Question: In one sentence, what is this figure communicating?
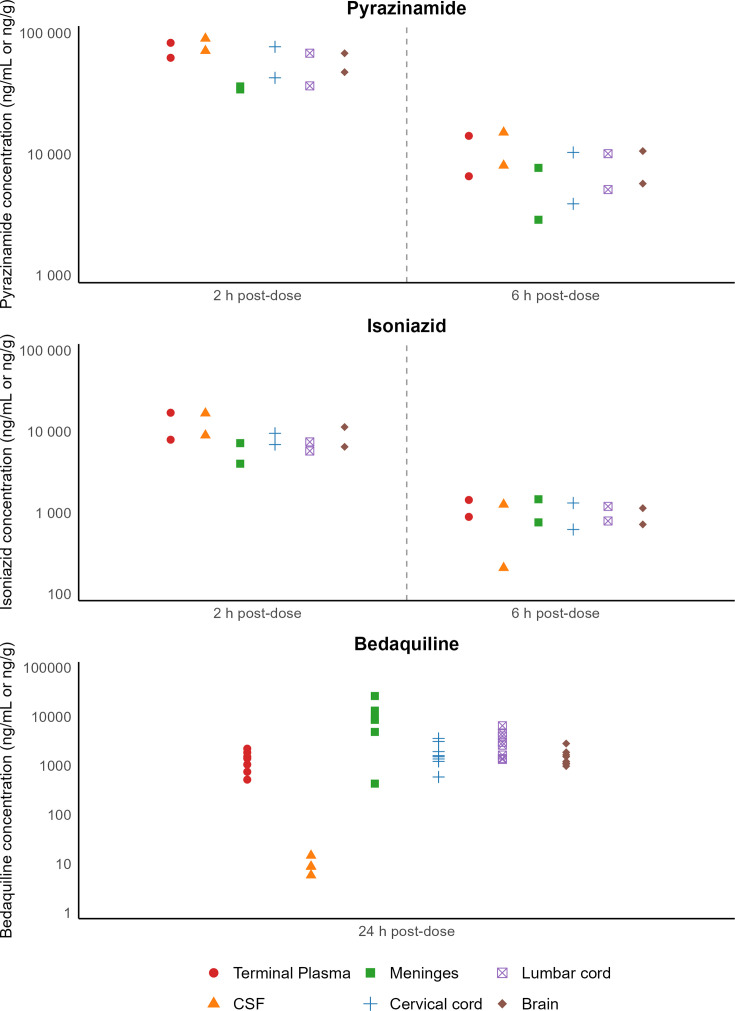
Answer: Concentrations of pyrazinamide, isoniazid, and bedaquiline in terminal plasma, CSF, and CNS tissues of rabbits with TBM. Samples were collected during necropsy at predefined post-dose timepoints, with all matrices from each animal collected at the same timepoint.